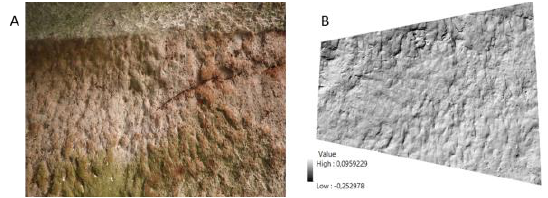
Figure 20. A detail picture of tool marks, B) DTM of a zone of the wall